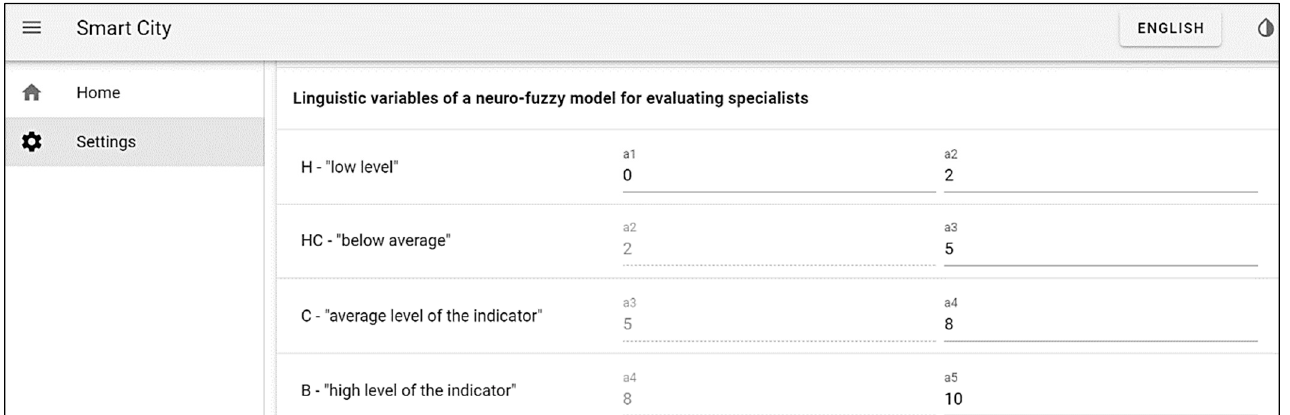
Figure 6. Head screen of the Smart City Concept Personnel Selection web platform.